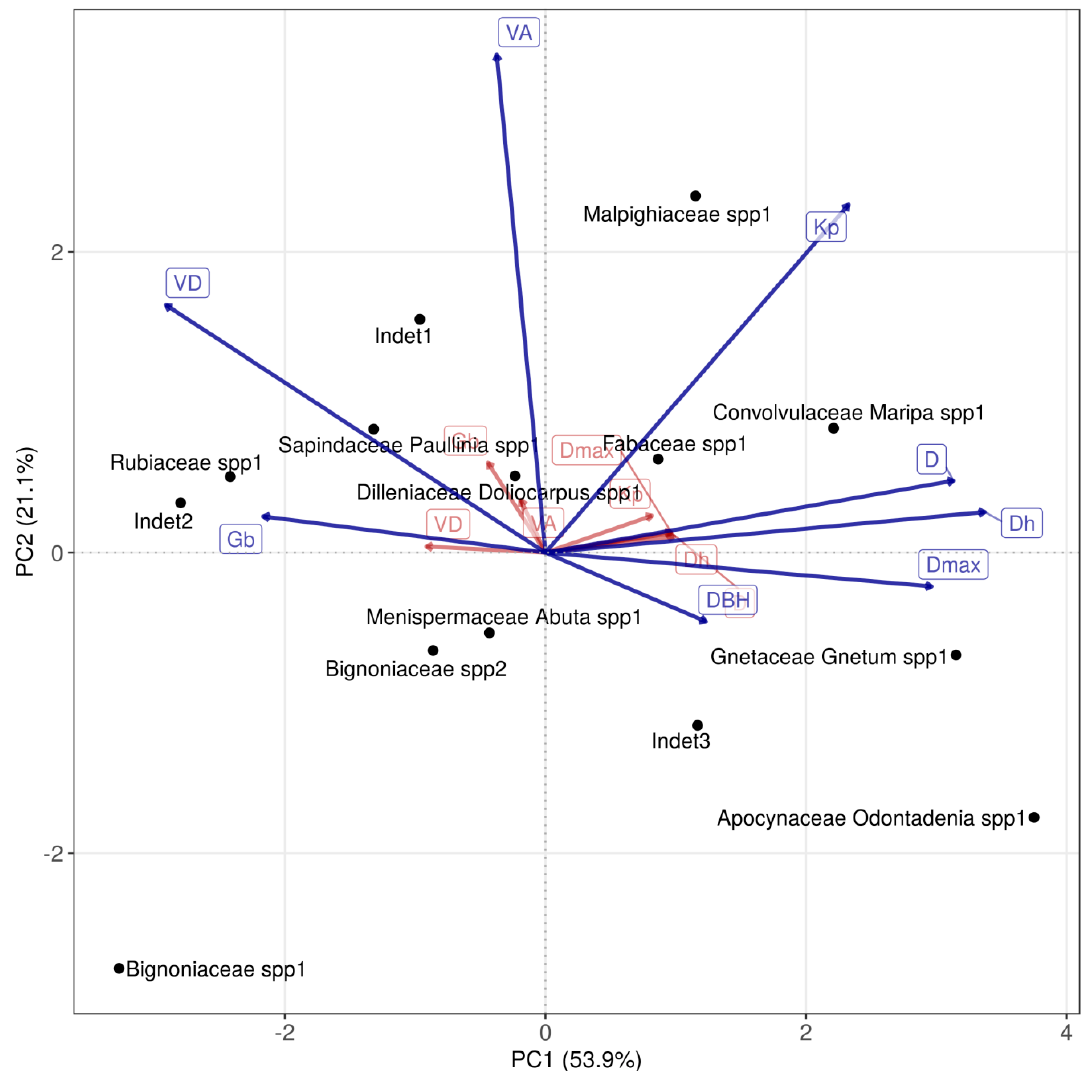
Figure 5. Principal-component analysis of the 8 wood traits of 22 liana individuals analyzed in this study (blue arrows) together with the species distribution in the principal component space. DBH = diameter at breast height, D = mean vessel diameter, D h = hydraulically-weighted diameter, D max = largest vessel diameter, K p = maximum stem hydraulic conductivity, VD = vessel density, G b = basic specific gravity, and VA = vessel area fraction. VD , D , D h , and K p were log10-transformed before analysis. Each studied liana individual was identified by its family and its genus whenever it could be determined with confidence (see Table 1). For comparison, we superimposed the principal component analysis of the overlapping traits from [39] achieved on 42 tropical tree species (red arrows).